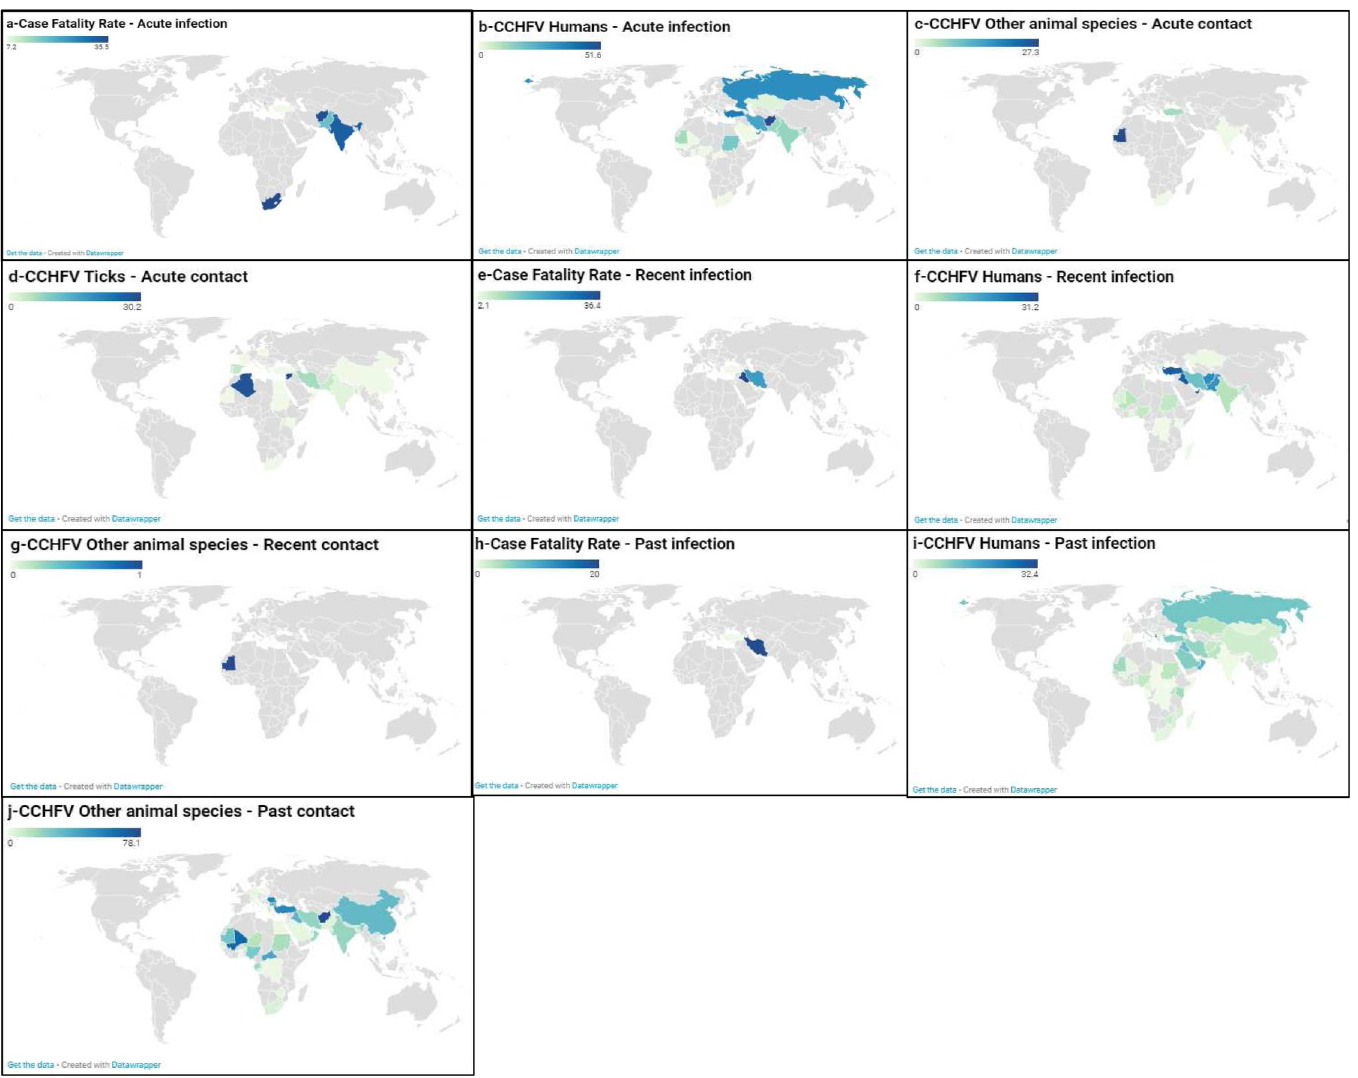
Fig 4. Global case fatality rate, prevalence, and seroprevalence estimate of Crimean-Congo hemorrhagic fever virus in humans, ticks, and other animal species. The letters (a, b, c, and d), (e, f, and g) and (h, I, and g) denote acute, recent and past CCHFV exposures, respectively. The letters (a, e, and h) shows the case fatality rate in humans. The letters (b, f, and, i), (c, g, and j) and (d) present the CCHFV detection rates in humans, other animal species and ticks, respectively. Map source: https://www.